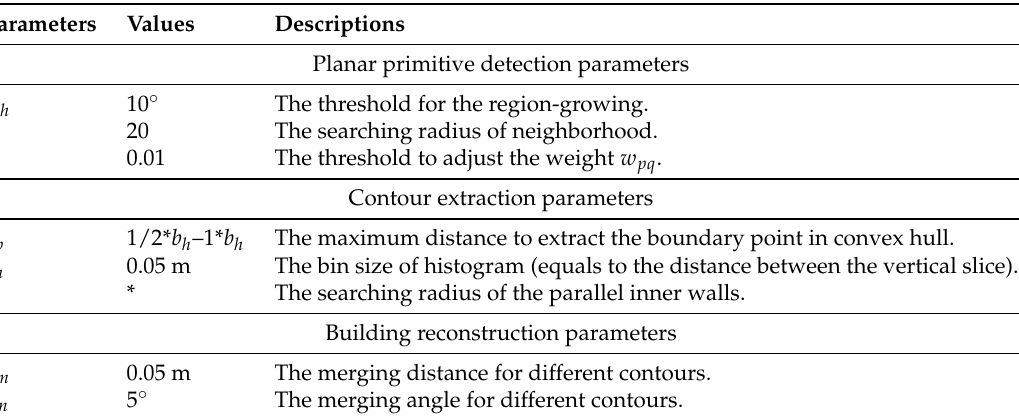
Table 3. Parameters of proposed layer-wise method.